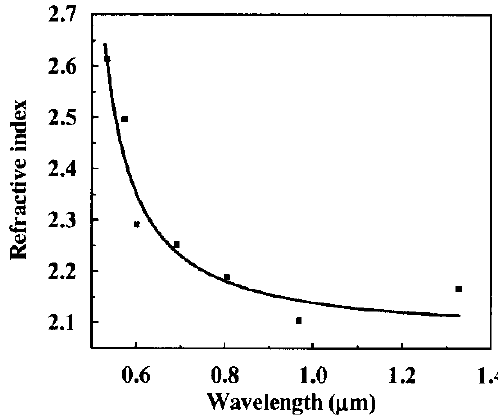
FIGURE 5 Refractive index of V 2 O 5 thin films spin-coated at